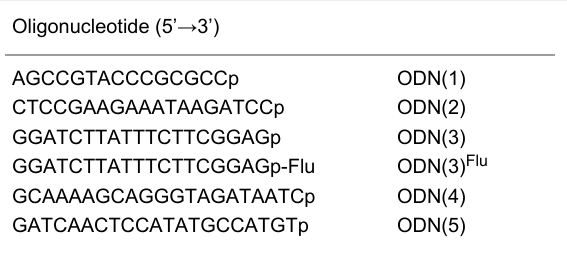
Table 3: Oligodeoxyribonucleotides used in the work. Oligonucleotide (5’ → 3’)